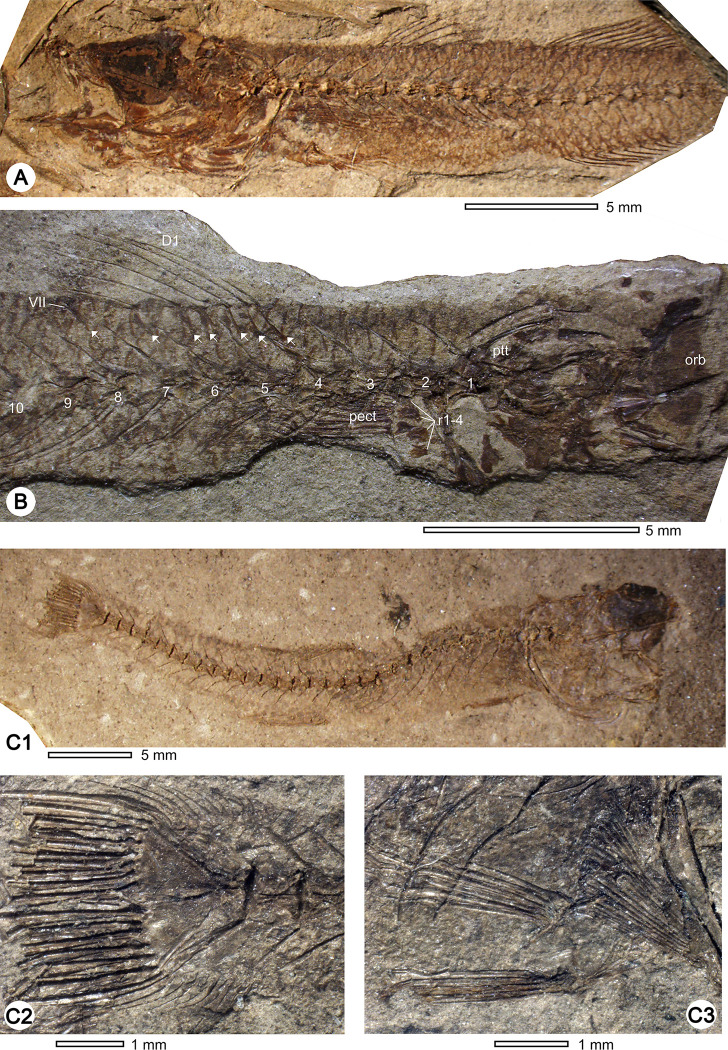
Fossil skeletons of †Pirskenius diatomaceus Obrhelová, 1961 showing details of fins.(A) Specimen PC 2772 exhibiting dorsal and anal fins (posterior part not preserved). (B) Counterpart of (A) (PC 2773) displaying radials (r1–r4) and remains of the pectoral fin (pect) and first dorsal fin with D1 pterygiophore formula 3(122110) (pterygiophores indicated by arrows). (C1–3) Specimen PC 2791, overview (C1), close-up of caudal fin with well-preserved procurrent rays (C2), close-up of separated pelvic fins (C3). Further abbreviation: ptt, posttemporal.